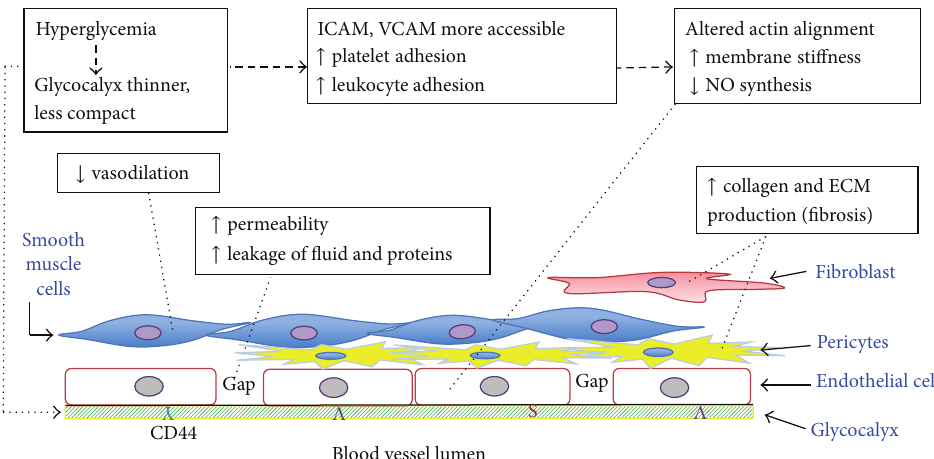
Figure 3: Summary of hyperglycemia-induced changes, within blood vessels and in their immediate surroundings, that involve alterations in